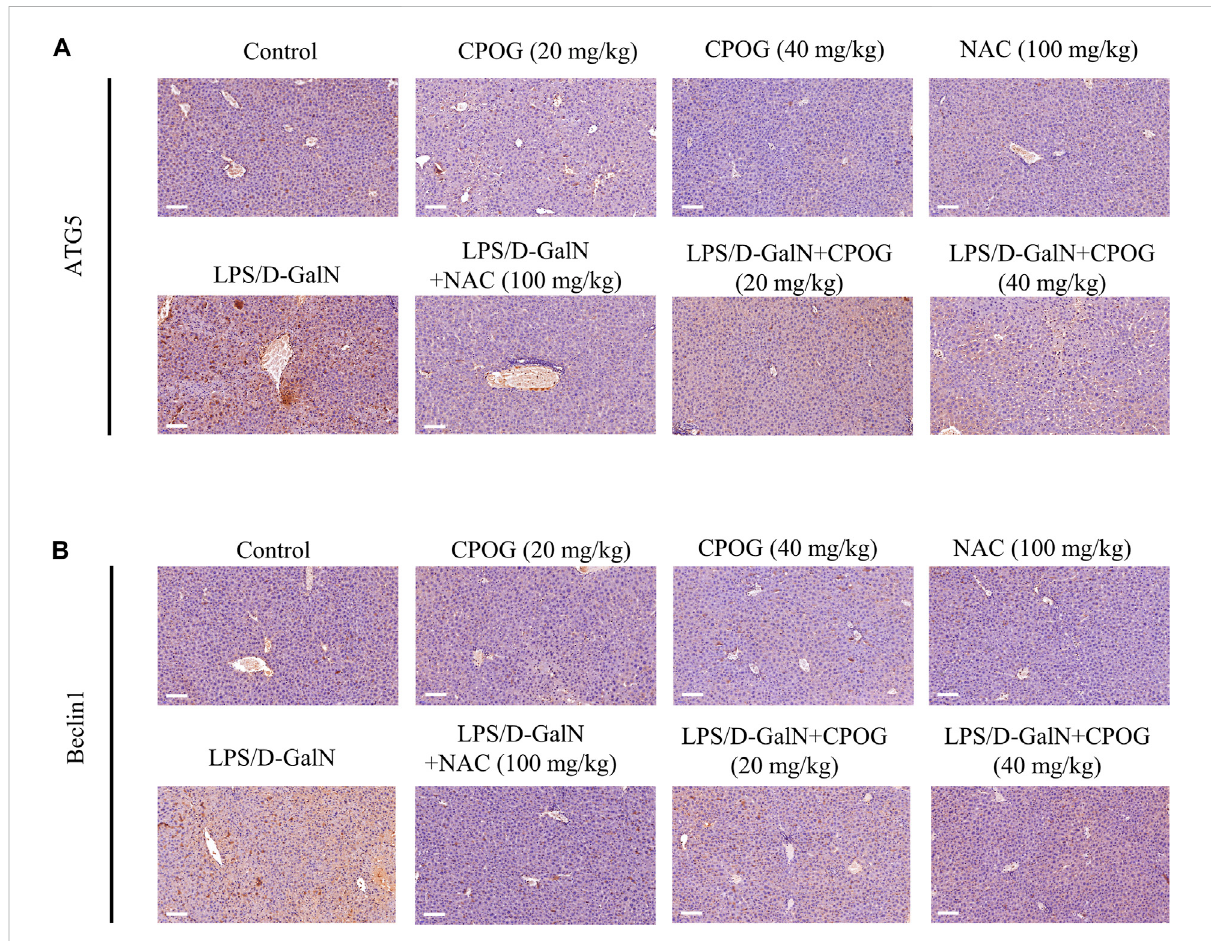
FIGURE 4 CPOGinhibitedtheexpressionofATG5andBeclin1inLPS/D-GalN-inducedALFmodel. (A,B) Immunohistochemistryassaywasperformedwith the indicated antibodies. The nucleus was stained with DAPI (blue color). Representative photographs were shown from vehicle mice, mice treated with CPOG (20 mg/kg), mice treated with CPOG (40 mg/kg), mice treated with NAC, mice treated with LPS/D-GalN, mice treated with LPS/D-GalN and NAC, mice treated with LPS/D-GalN and CPOG (20 mg/kg), mice treated with LPS/D-GalN and CPOG (40 mg/kg). Scale bar = 100